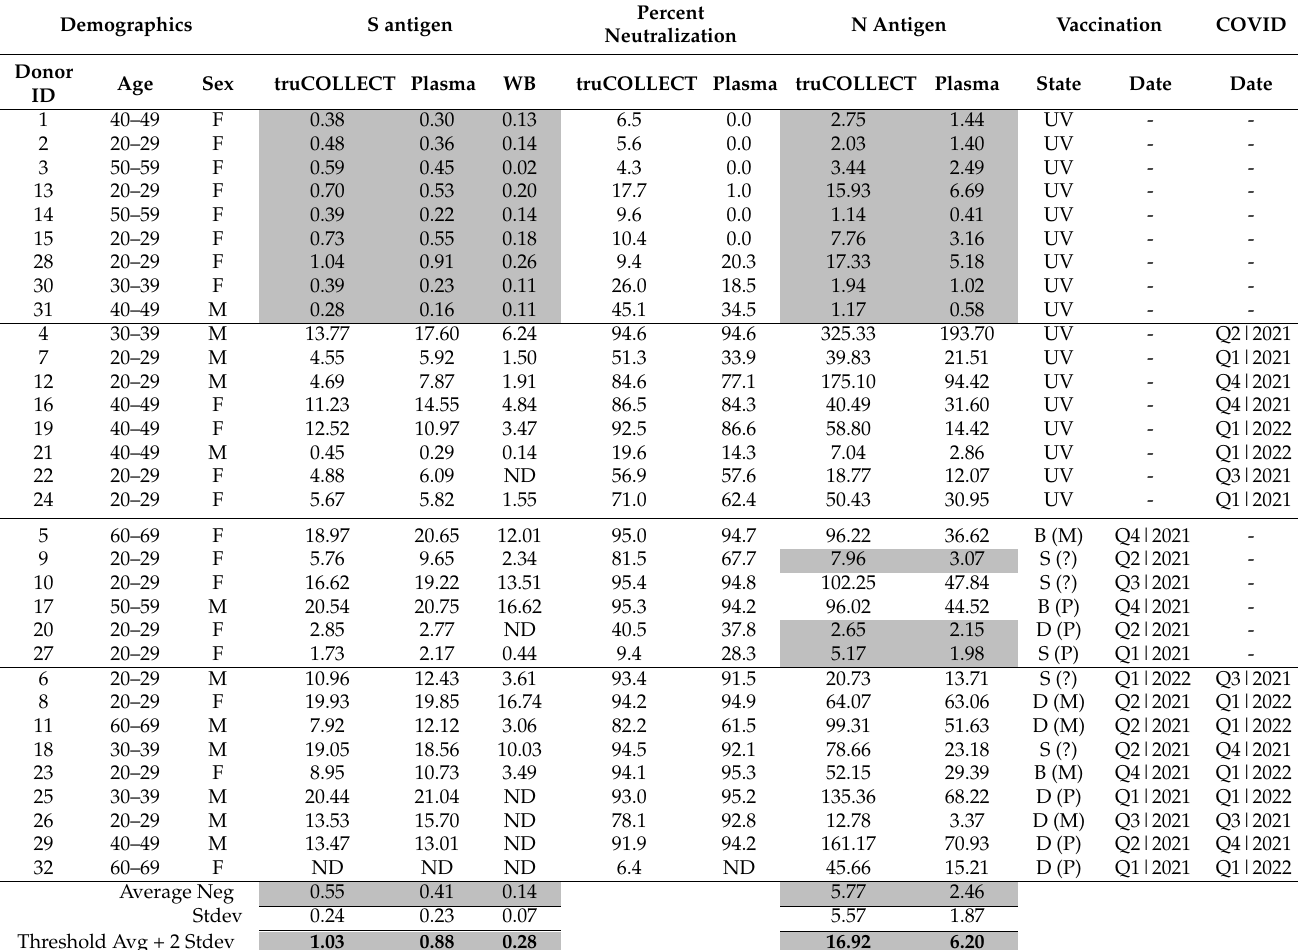
Table 1. Donor Information. A table summarizing demographics, vaccination and past SARS- CoV-2 infection status of volunteers, and matching ELISA data. Data are sorted by vaccination status and past COVID-19 infection information given at time of collection, ‘unvaccinated/no- COVID’, ‘unvaccinated/COVID’, ‘vaccinated/no-COVID’, and ‘vaccinated/COVID’. The units for the different ELISA data are Ratio Units (S-protein), Units/mL (N-Protein), and % (Neutralization Assay). Abbreviations: WB: Whole Blood (Fingerstick Microtainer); truCOLLECT: Whole Blood (Fingerstick truCOLLECT); Plasma: Plasma (obtained from phlebotomy-collected whole K 2 EDTA blood); M: Male; F: Female; S: Single Vaccination; D: Double Vaccination; B: Double Vaccination + Booster; ?: Unknown Vaccination Status; M/P/?: Moderna/Pfizer/Unspecified Vaccine; UV: Unvaccinated; ND: No Data; grey fields were used to calculate the NEG threshold (average negative value + 2 standard